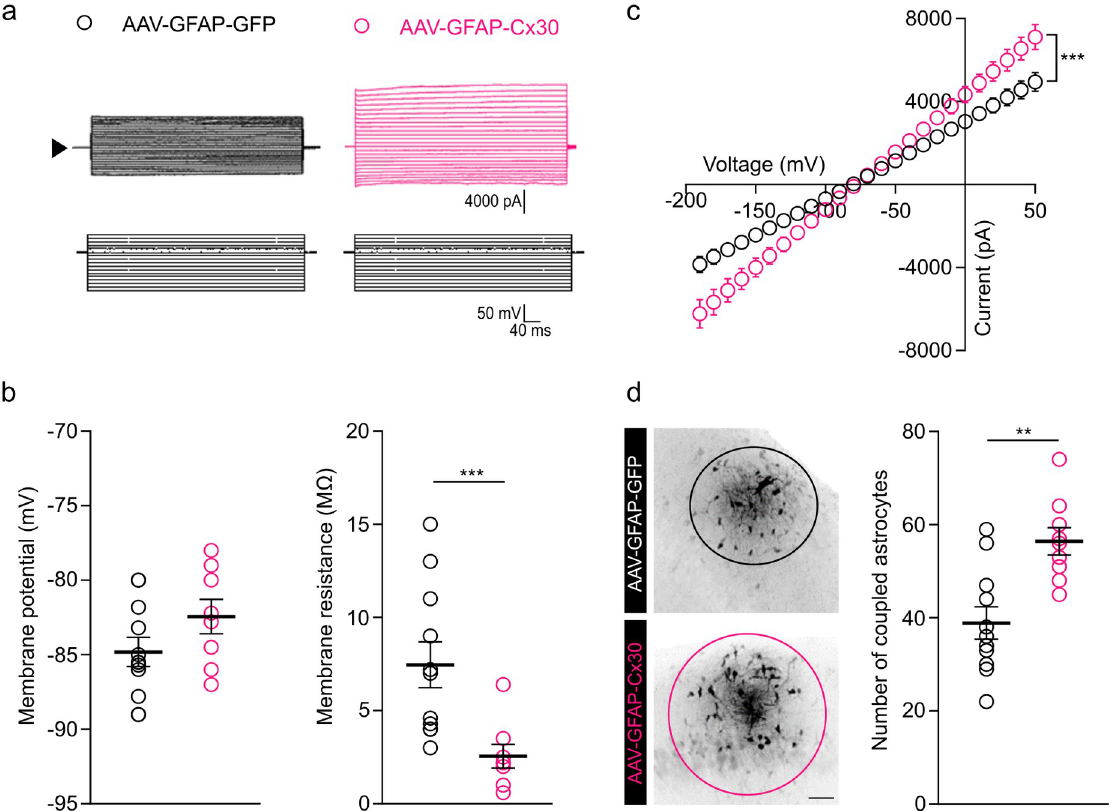
Fig 2. Upregulation of Cx30 increased passive astrocytic currents and the size of the astroglial network. (a) Representative whole-cell current profiles evoked by current injections from GFP-labeled astrocytes clamped at − 80mV. ( b )The membrane potential of astrocytes is unchanged after AAV-GFAP-Cx30 ( n = 9 astrocytes from 6 mice) compared to AAV-GFAP-GFP ( n = 11 astrocytes from 5 mice) injection ( p = 0.1572, Mann–Whitney test). Membrane resistance is decreased after AAV-GFAP-Cx30 ( n = 9 astrocytes from 6 mice) compared to AAV-GFAP-GFP ( n = 11 astrocytes from 5 mice) injection ( *** p < 0.001, Mann–Whitney test). (c )Current–voltage curve (IV curve) of astrocytes. Astrocytic currents were increased after AAV-GFAP-Cx30 ( n = 9 astrocytes from 6 mice, pink) compared to AAV-GFAP-GFP transduction ( n = 11 astrocytes from 5 mice, black) injection ( *** p < 0.001, interaction: F (24,425) = 9.0, two-way ANOVA). ( d) Images of gap junction–mediated biocytin coupling in CA1 from brain slices following injection of AAV-GFAP-GFP (black) or AAV-GFAP-Cx30 (pink). Scale bar: 50 μ m.Gap junction coupling is significantly enhanced, as quantified by counting the number of coupled cells after 10 min of biocytin injection in a single astrocyte through a patch pipette after AAV-GFAP-Cx30 ( n= 9 slices from 6 mice) transduction compared to AAV-GFAP-GFP transduction ( n = 11 slices from 5 mice). Individual numerical values are indicated in S1 Data. ** p = 0.0012, Welch t test.